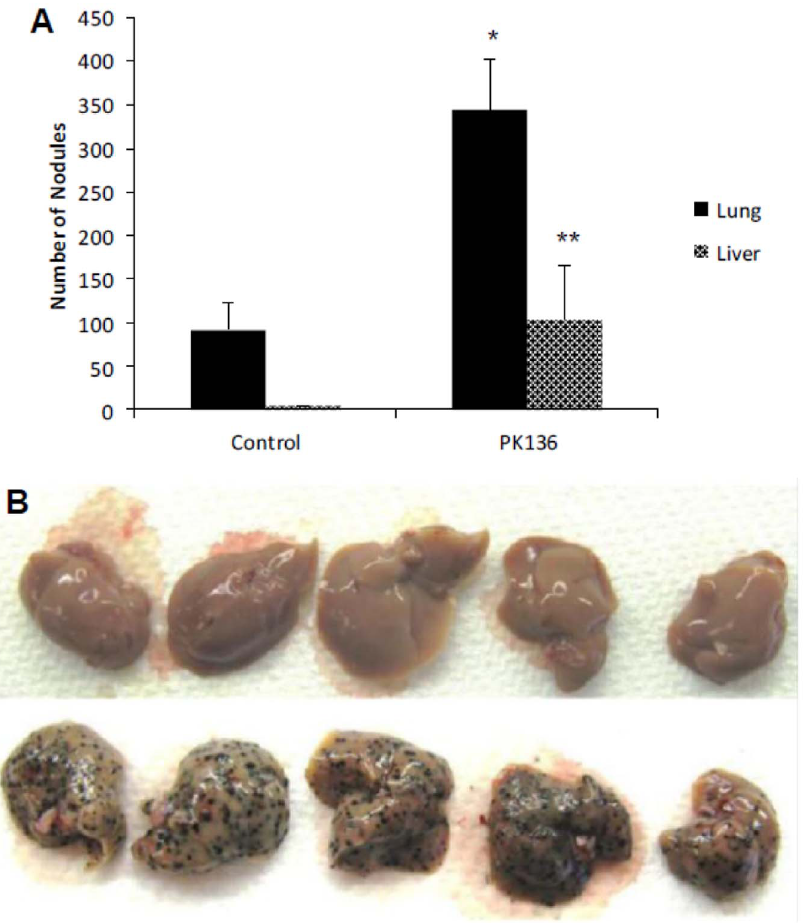
Figure 1. NK depletion results in establishment of liver tumor nodules and increased pulmonary tumor load. B6 mice were given control Ig or PK136 on day 2 3 and day 0 (i.p.) followed by i.v. injection of B16 tumor on day 0. Mice were euthanized on Day 14 and tumor nodules counted; there were five mice per group. The increase in tumor nodules in the lung was significant at p=0.019 (indicated by *). The increase in liver tumor nodules was significant at p=0.005 (indicated by **). The design of the experiment was such that all mice groups were processed simultaneously. A visual depiction of a similar experiment is in (B) where the bottom row shows livers from NK-depleted mice.